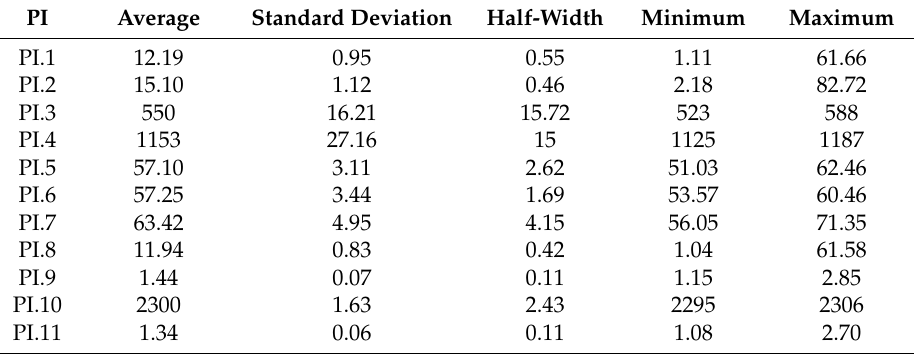
Table 7. Statistical results of each performance indicator when the breakdowns are allowed.